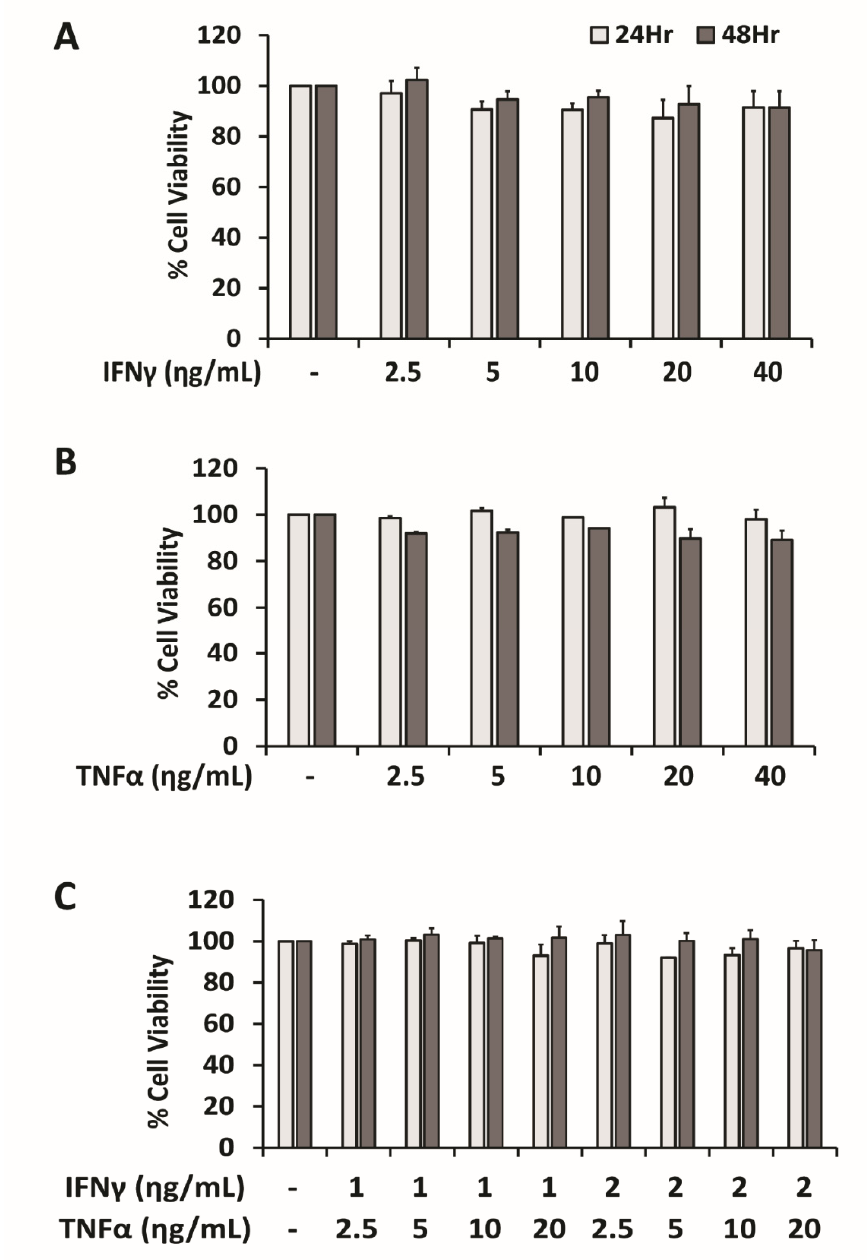
Figure 1. Individual or combination treatments of cytokines: IFN γ and/or TNF α are not toxic to HepG2 cells. HepG2 cells were treated with either IFN γ ( A ) or TNF α ( B ), or a combination of IFN γ and TNF α ( C ) at various concentrations (ng/mL) for 24 and 48 h and percentage of cell viability was assessed by MTT assays. Data are presented as mean ± SD, n = 3.